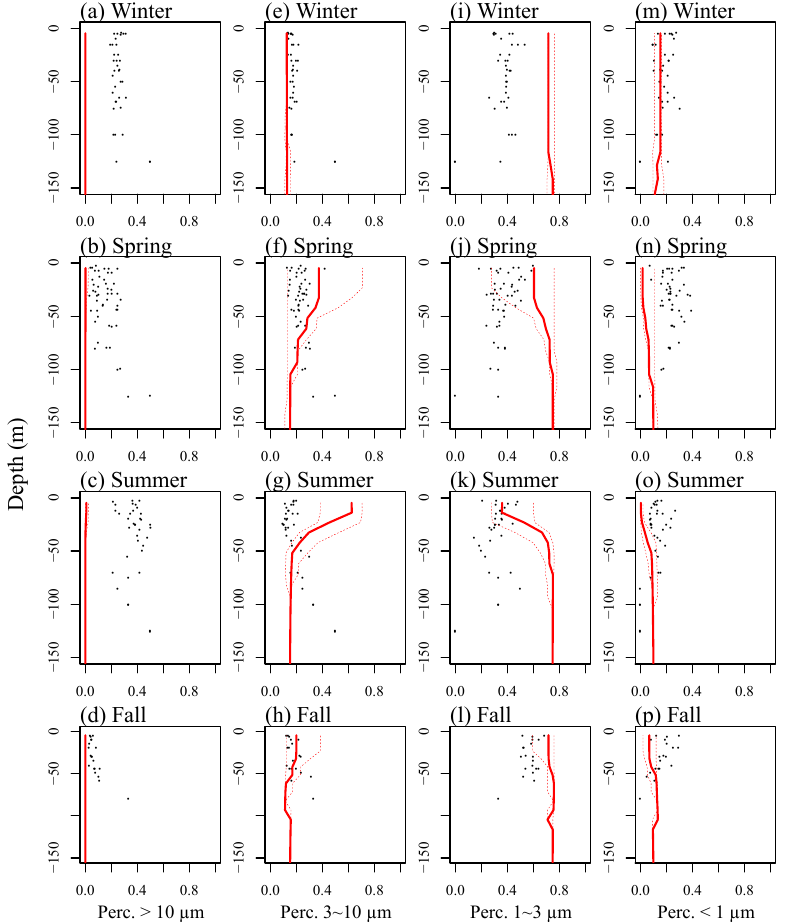
Figure 8. Model fittings for the percentages of the four size fractions of Chl a at station K2. (a)–(d) Percentages of > 10µm fraction, (e)–(h) 3–10µm, (i)–(l) 1–3µm, and (m)–(p) < 1µm.